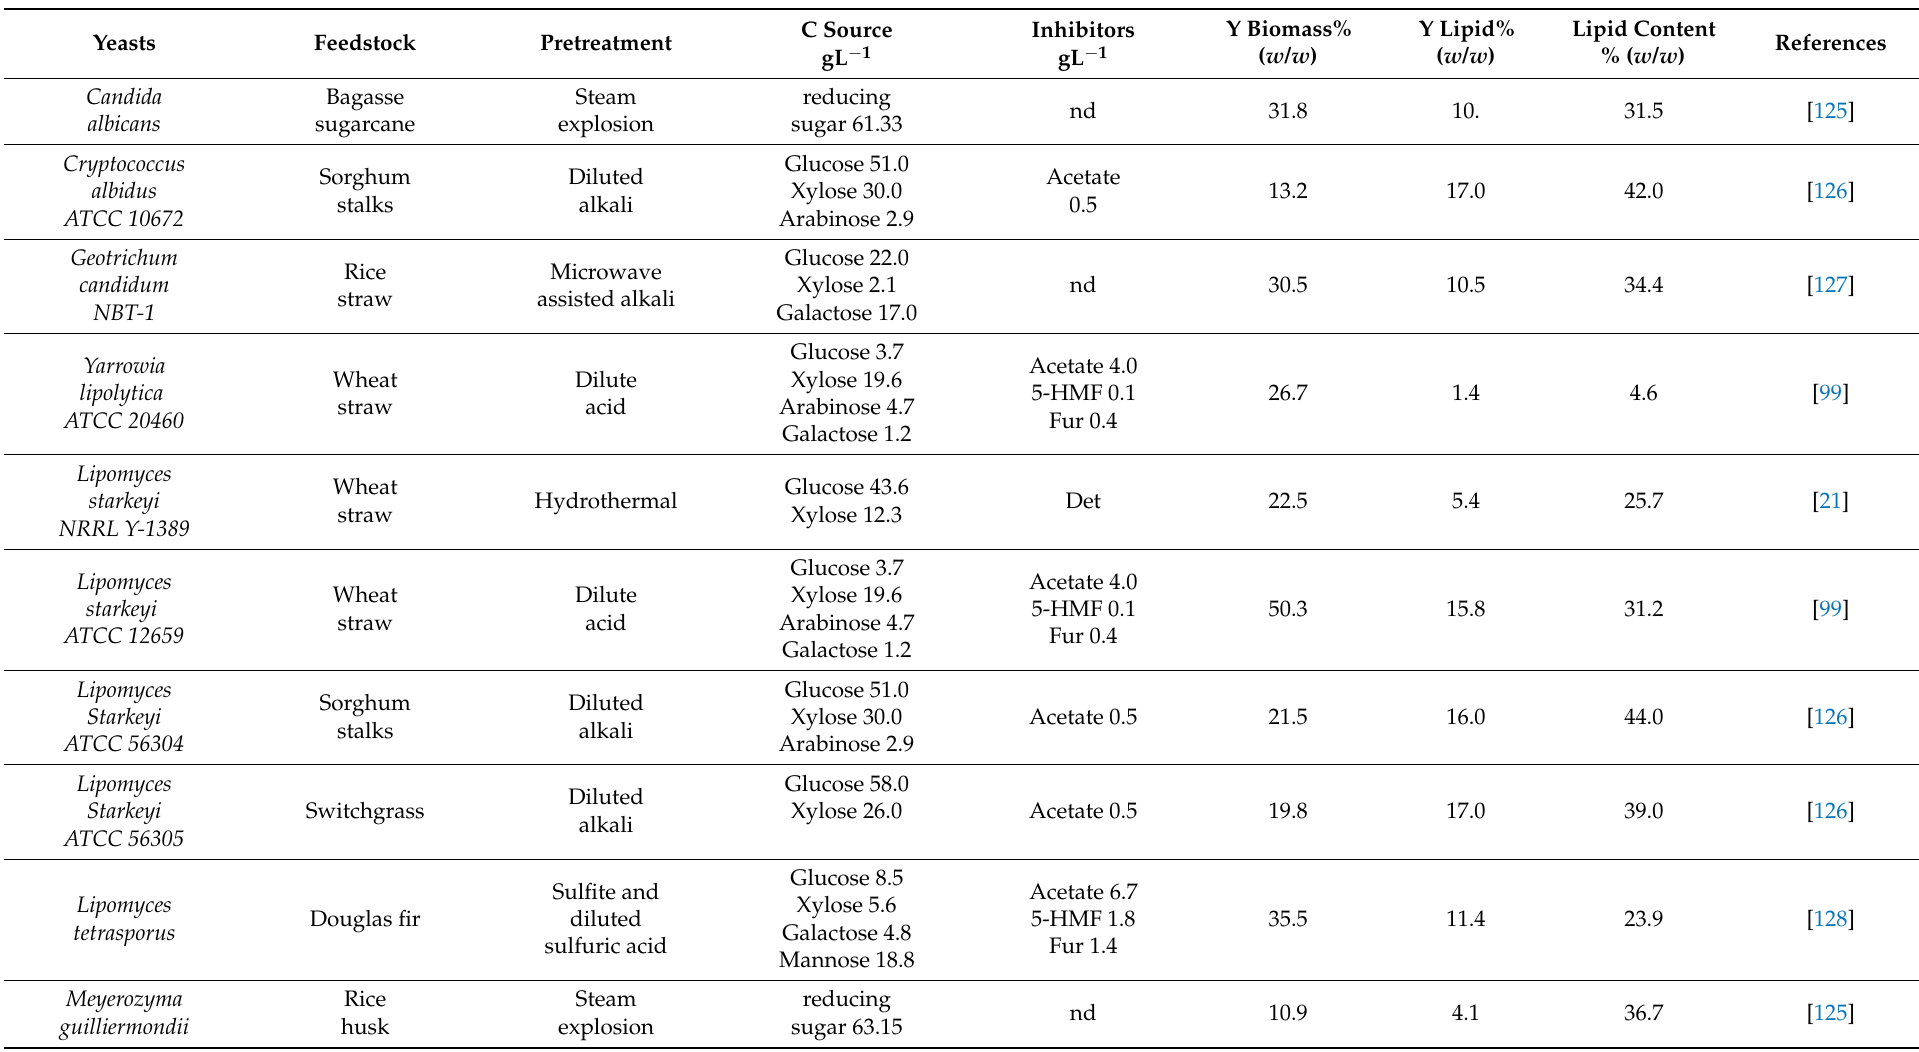
Table 2. Growth of different oleaginous yeasts strains on lignocellulosic hydrolysates with inhibitors and detoxified